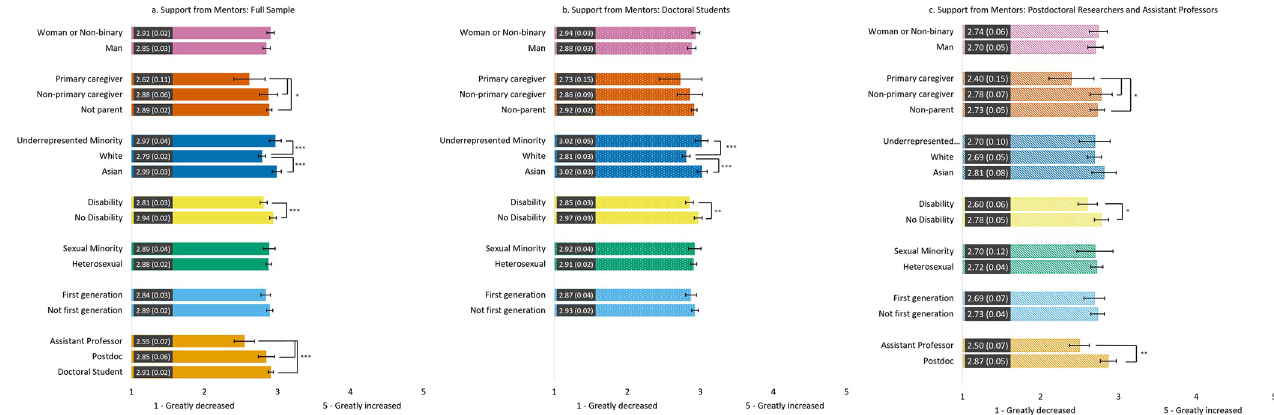
Fig 4. Estimated marginal means of reported change in mentor support due to the COVID-19 pandemic for the full sample (4a) and the doctoral student (4b) and postdoc/asst prof (4c) subsamples. Participants were asked to rate the degree to which their support from mentor(s) changed on a Likert scale from 1 = Greatly decreased to 5 = Greatly increased . Error bars represent the 95% CI. Numeric values in each bar are the estimated marginal mean and standard error. � indicates p < .05, �� indicates p < .01, and ��� indicates p < .001. See S6 Table in S1 File for results of each model.